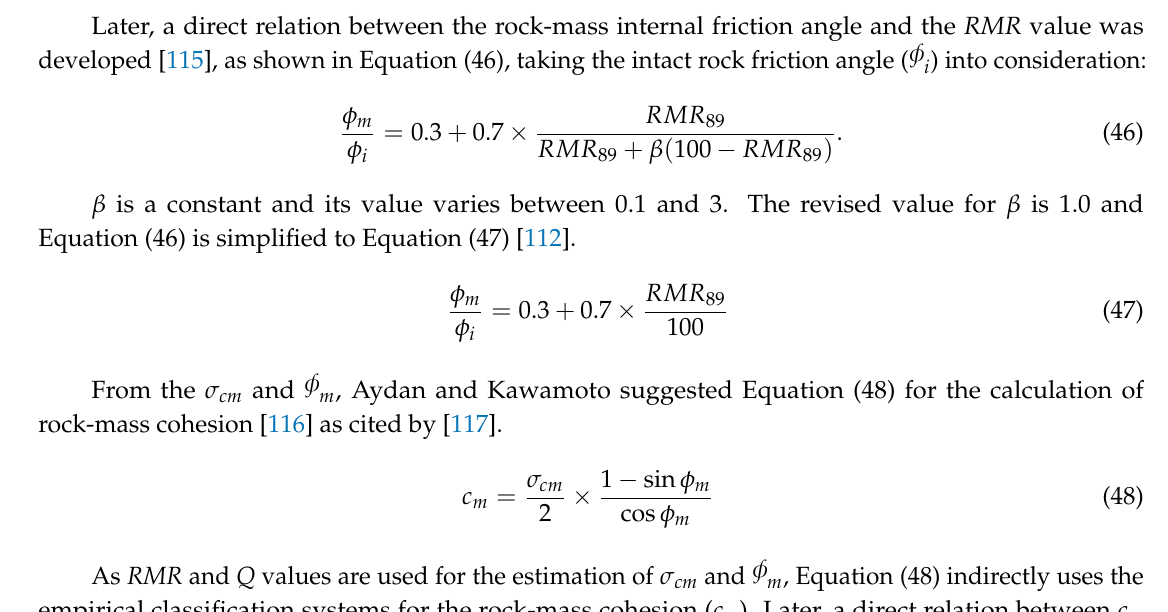
Table 4. Equations for calculation of E m without E i .